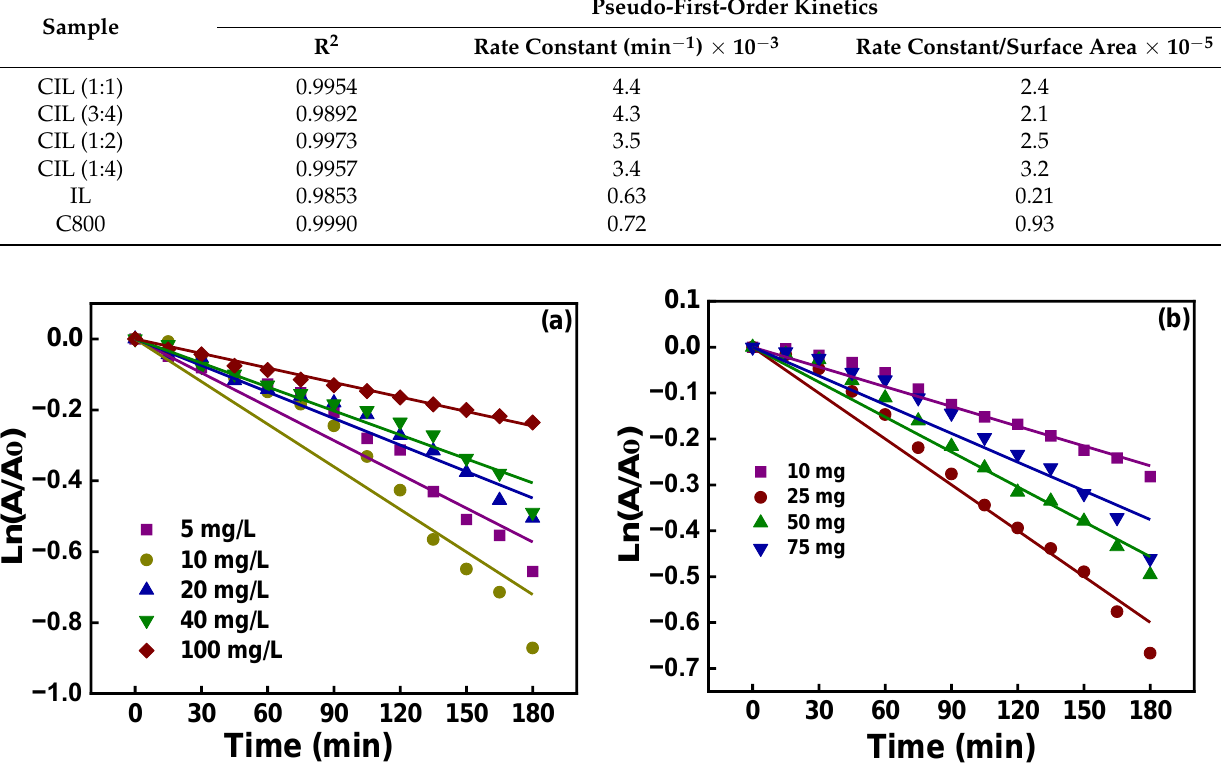
Figure 11. Effect of ( a ) initial dye concentration and ( b ) weight of catalyst on photocatalytic activ- ity. Table 4. Pseudo-first-order rate constants showing the effect of dye concentration on the photocata- lytic activity.